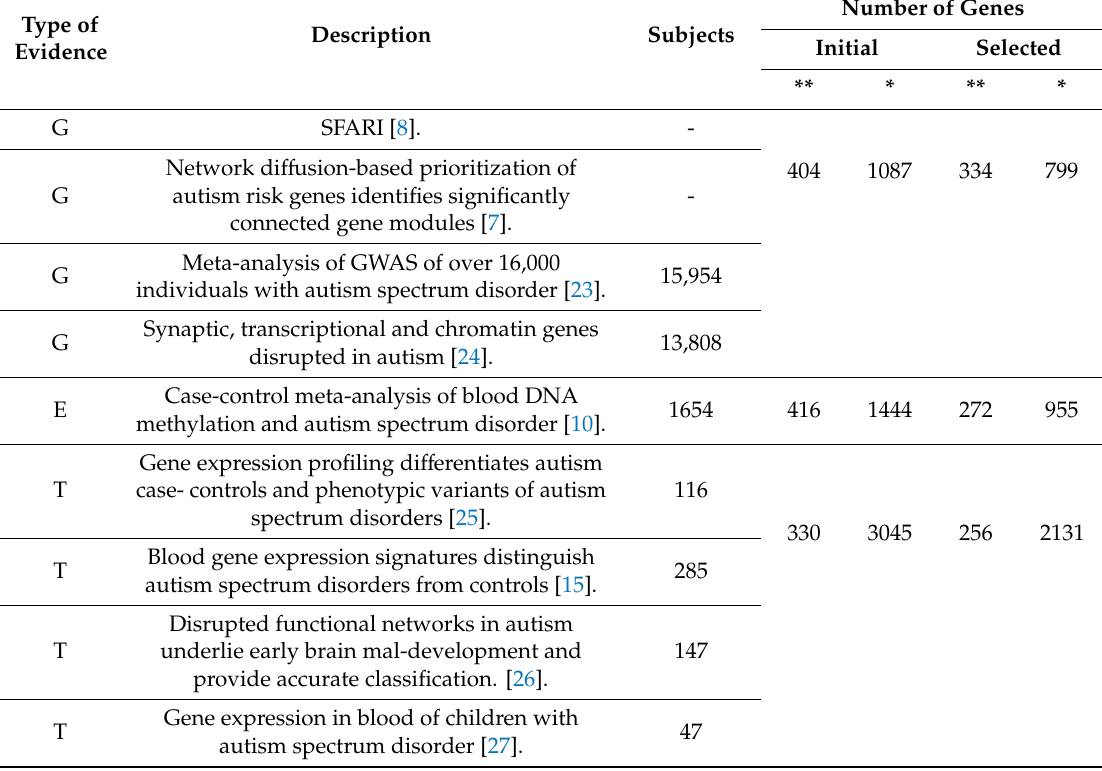
Table 1. Datasets considered in this study. Selected: The number of genes for which at least a high confidence interaction with any other gene is catalogued in the STRING database (see